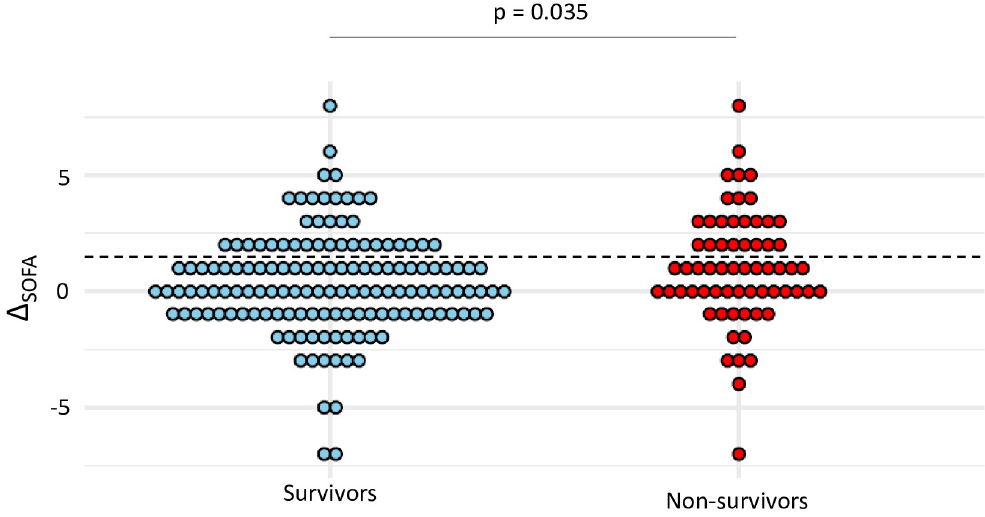
Fig 2. Dot plots of Δ SOFA in survivors and non-survivors. Values of Δ SOFA are shown as single dots for each patient. The dash line separates patients with a Δ SOFA � 2 from those with a Δ SOFA < 2. SOFA sequential organ failure assessment; VAP ventilator-associated pneumonia; VAT ventilator-associated